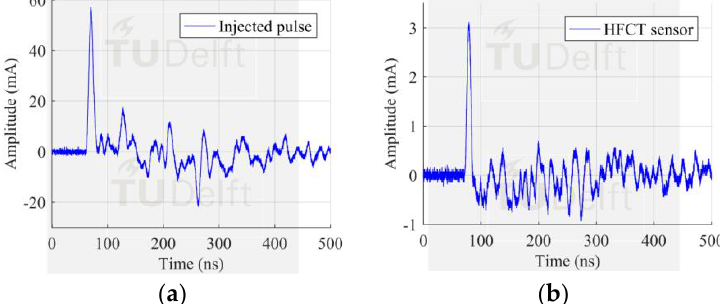
Figure 5. Results with configuration 1, ( a ) pulse injected at the test cell position; ( b ) pulse measured by HFCT 1. Only one sensor installed and 15 parallel current paths.